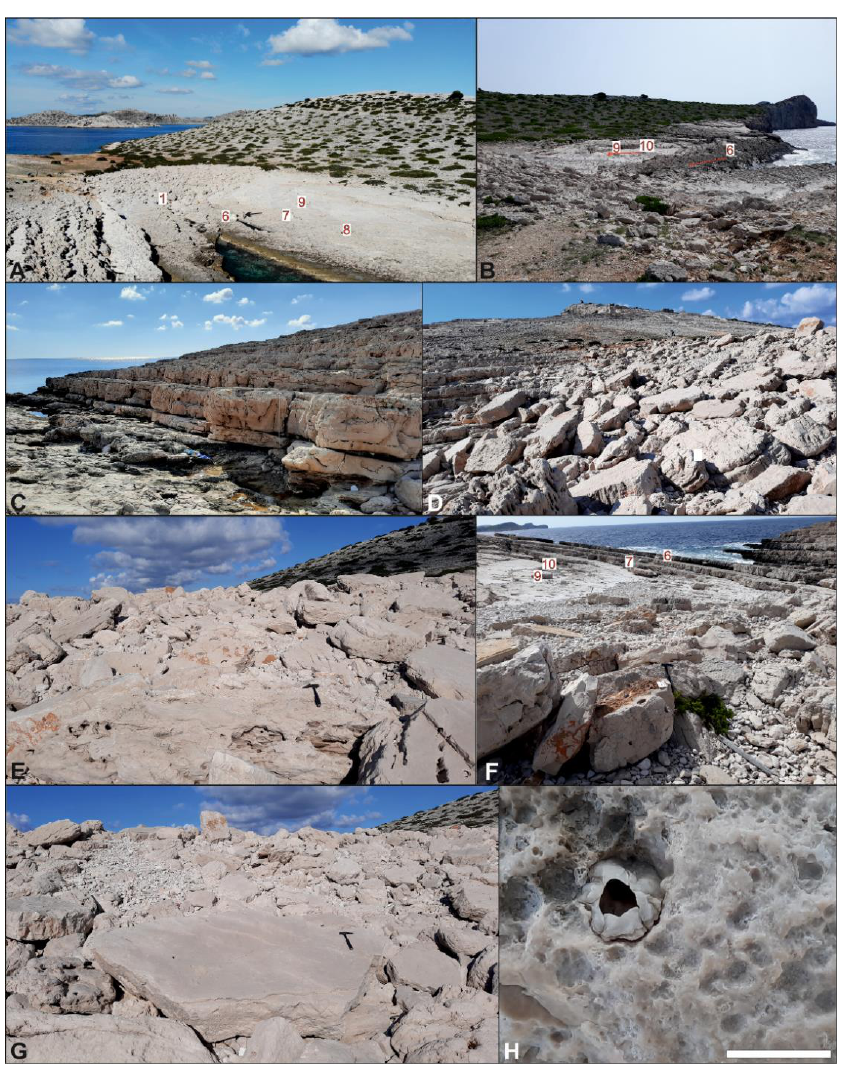
Figure 5. Field photographs of the Mana coarse-clast deposit, solitary boulders, and the bedrock limestones. The selected boulders are marked by numbers. ( A ) 2020 panoramic view from the SE to the tip of the shallow inlet, with eroded limestone bedrock, recognizable boulders (1, 6, 7, 8, 9), the deposit, and the brown soil in the background. Black arrow indicates a person for scale at the recently moved boulder 6. ( B ) 2018 panoramic view to the east on the proximal (SE) part of the deposit and a few solitary boulders in the front of the deposit (MB 6, 9, and 10) that were displaced between 2018 and 2020 (southern cliff in the background). ( C ) 2020 view of bedding discontinuities within the central part of the limestone bedrock in front of the deposit. White scale bar is a meter long. ( D ) 2020 view of the frontal part of the deposit and the boulders imbricated to the SE. ( E ) 2020 view of one of the largest boulders (3, hammer) that is strongly corroded and characterized by remnants of Lithophaga borings. ( F ) 2018 photo of a group of boulders in the frontal part of the deposit characterized by remnants of reddish-brown calcrete that is found also at the contact of the bedrock with the brown soil. Note three boulders in front of the deposit (6, 9, and 10) that were displaced between June 2018 and October 2020, and one (7) that was not displaced. ( G ) 2020 photo of the overturned platy boulder (1, hammer) in the frontal part of the deposit. ( H ) Corroded biogenic carbonate encrustations and the barnacle shells from the present-day (overturned) bottom side of boulder 1, originally on the upper bedding surface of the bedrock limestone (scale bar is 1 cm).